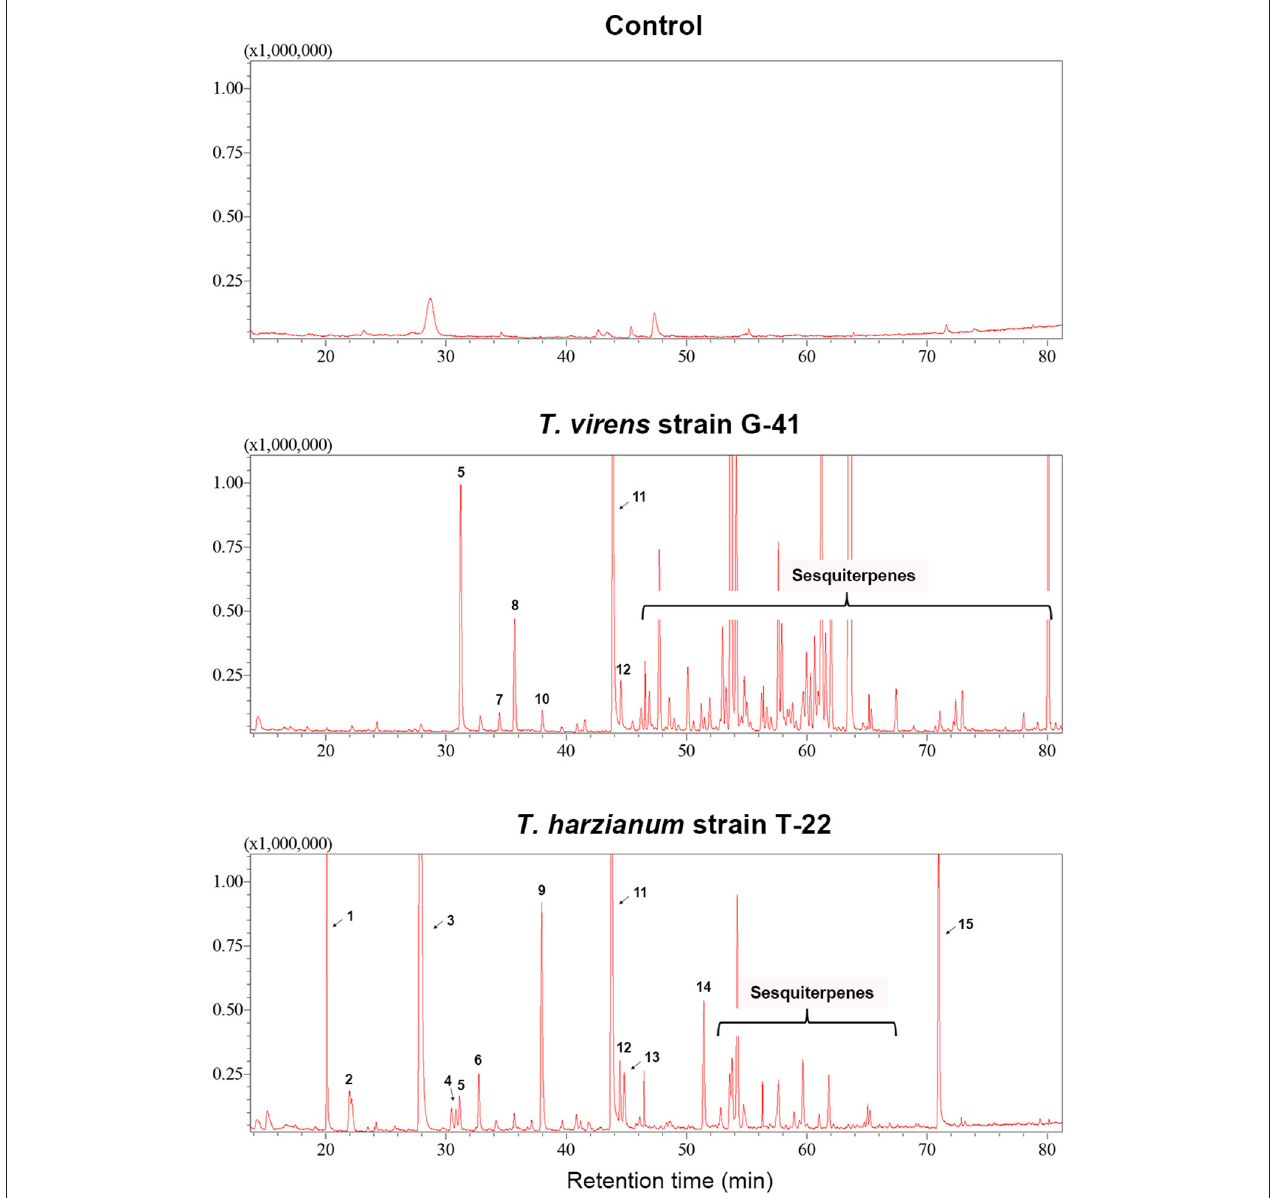
FIGURE 3 | VCs produced by T. virens and T. harzianum . Headspace volatiles extracted from Control (PDA only) and cultures of T. virens strain G-41 and T. harzianum strain T-22 on PDA were separated using GC. The identity of compound corresponding to each numbered peak is shown in Table 3 . X-axis, retention time (in minutes); Y-axis, intensity (counts per